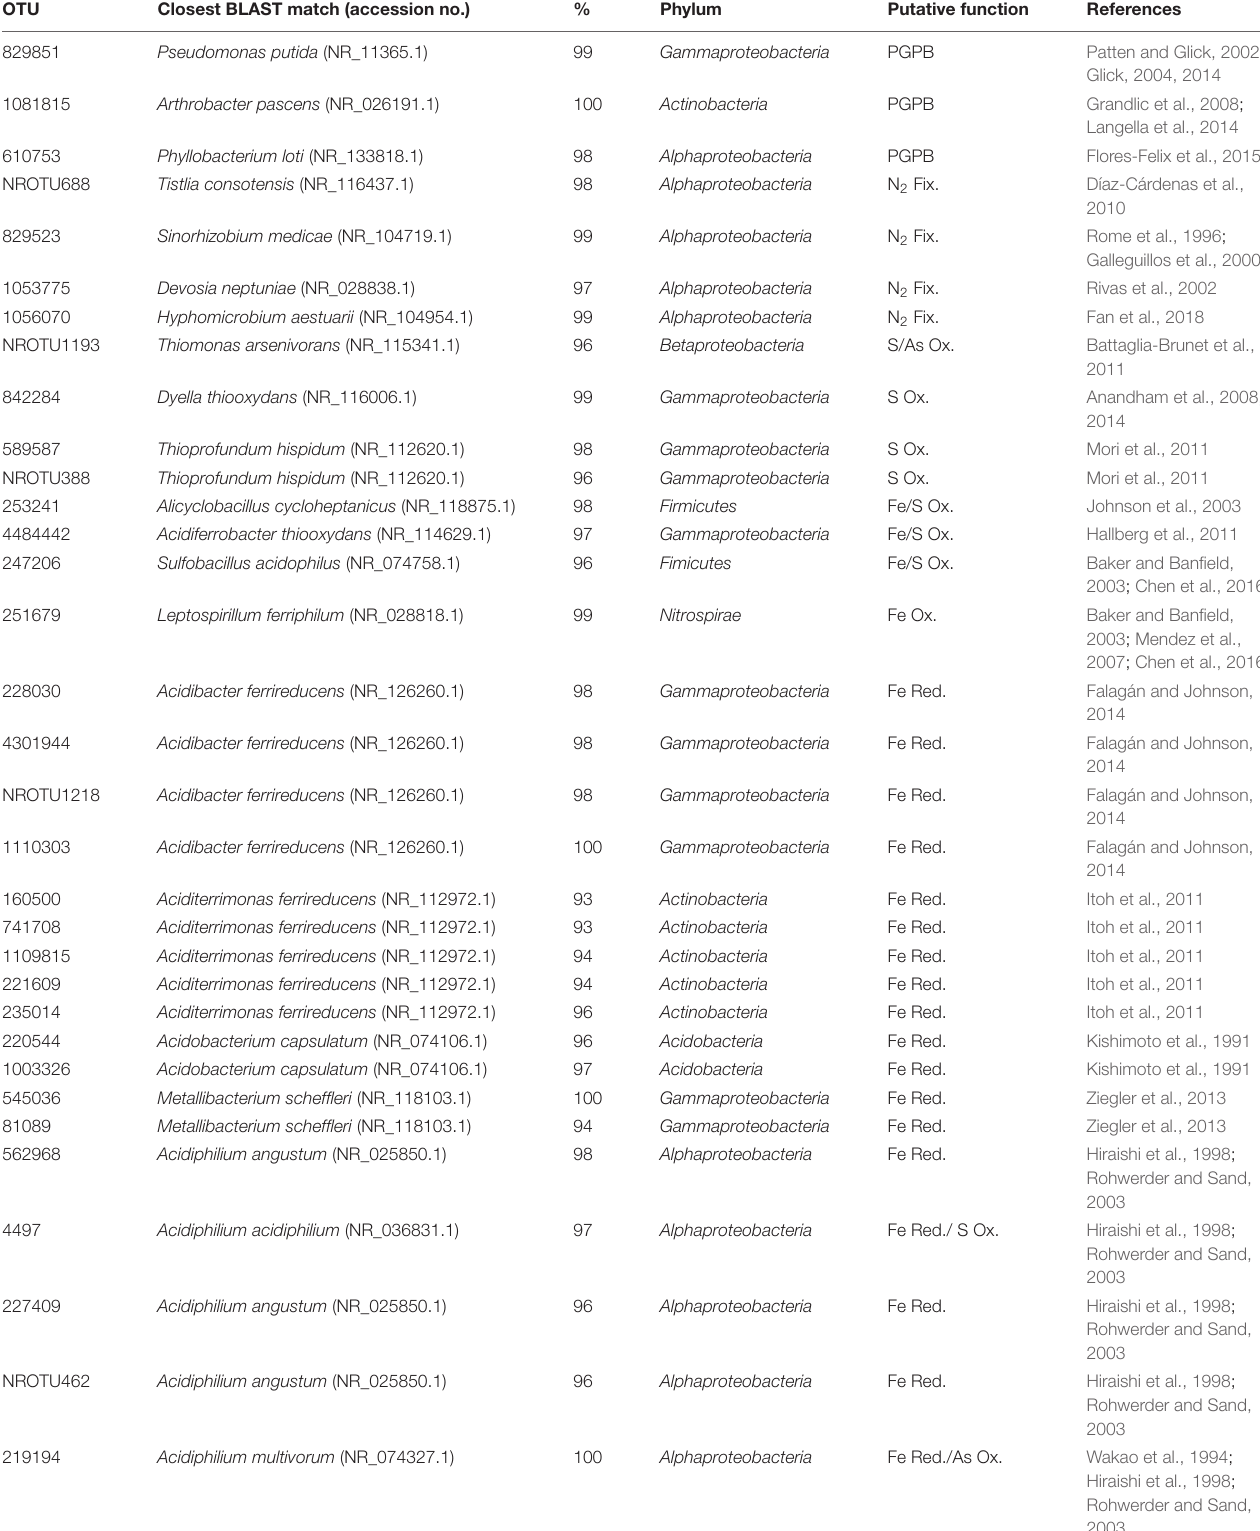
TABLE 2 | Identities of putative N 2 -fixing, plant growth-promoting bacteria (PGPB), Fe/S oxidizing, and Fe reducing within the top 100 most abundant OTUs. OTU Closest BLAST match (accession no.) % Phylum Putative